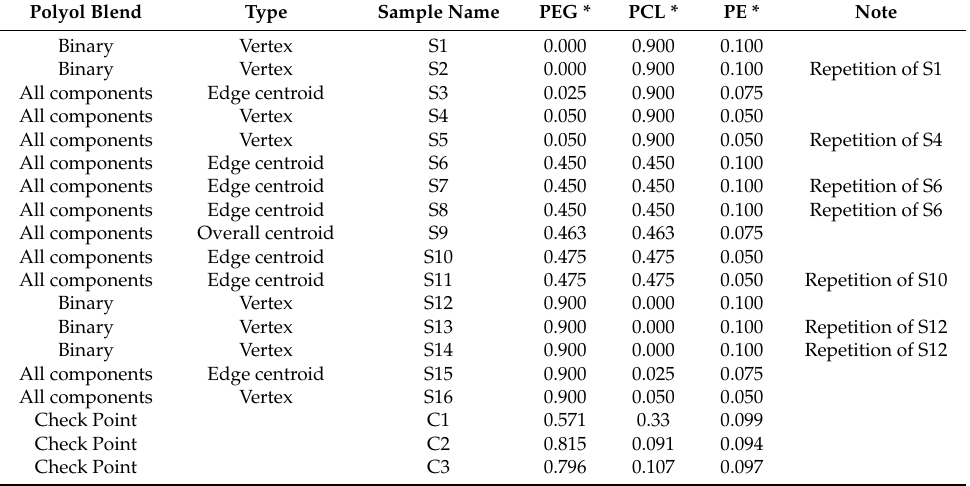
Table 7. Description of mixture design for the study of polyol blend